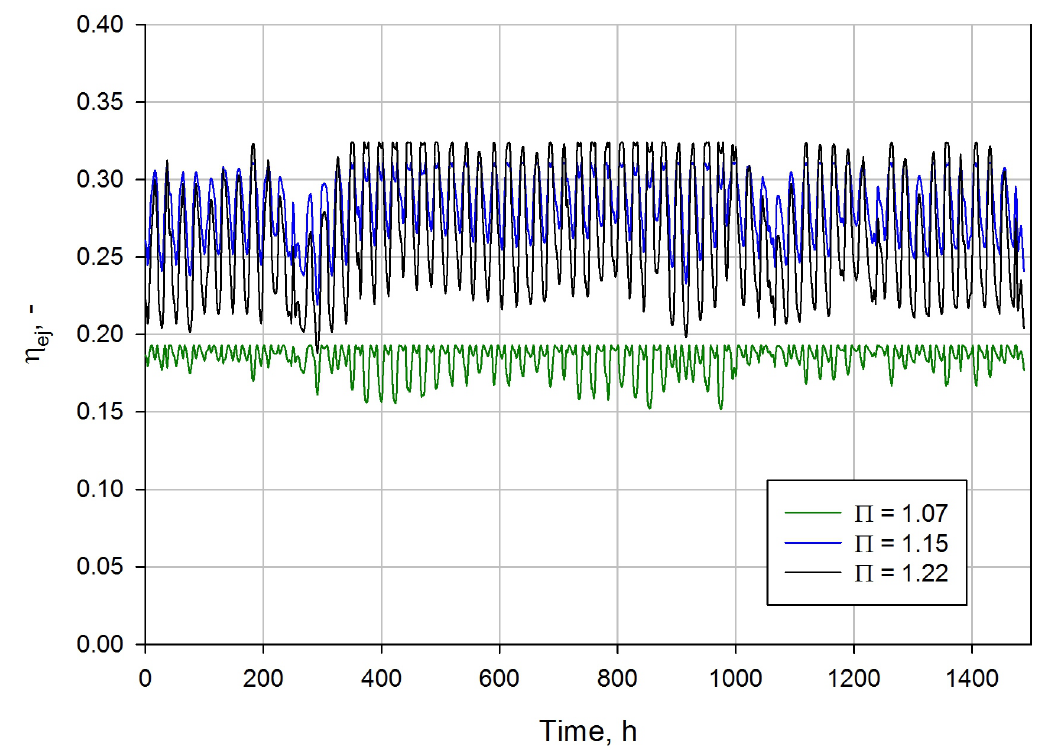
Figure 9. The ejector efficiency at different pressure ratios during the summer campaign in the Mediterranean